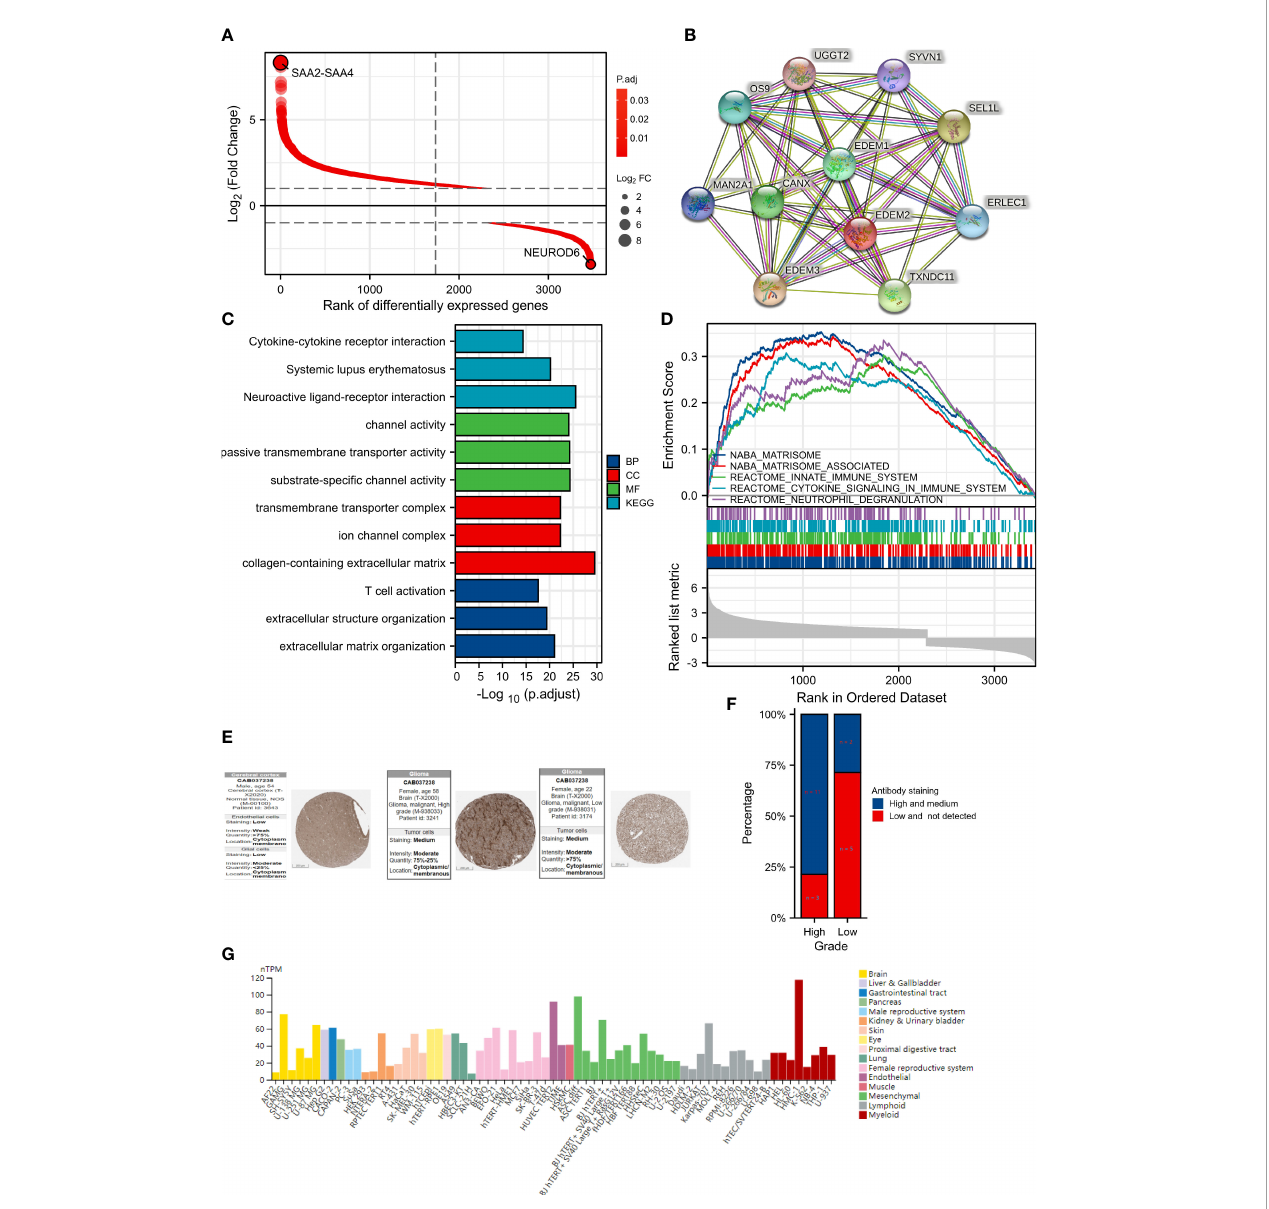
FIGURE 5 Differential genes (DEGs) analysis between different expression groups and protein expression analysis of EDEM2. (A) DEGs Ranking Plot. (B) EDEM2 protein interaction network. (C) The results of the GO and KEGG analyses. (D) GSEA enrichment analysis results. (E) Immunohistochemical images of pathological and normal tissues on the HPA sites of varying grades. (F) Bar plot of EDEM2 protein expression of glioma samples in the HPA website. (G) Expression of EDEM2 in cell